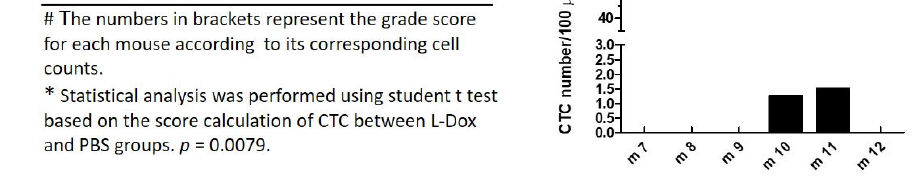
Figure 4. Chemotherapy reduced tumor growth but induce CTCs in vivo. ( A ) Mice treated with L-Dox at a dose of 5 mg/kg once/week for 3 weeks (red arrows indicate L-Dox administration) showed a significant suppression of tumor growth and tumor weight. Data are presented as mean + SEM, N = 6. p -value was calculated with a two-sided unpaired Student’s t test. ( B ) CTCs were captured and identified in both groups of mice. Scale bar, 40 µ m. ( C ) Table listing the levels of CTCs detected in mice treated with L-Dox or PBS. Statistical analysis was performed based on the grading score system according to the CTC count of each mouse (score 1: 0 CTCs; score 2: 0–10 CTCs; score 3: 10–100 CTCs; score 4: >100 CTCs) using a two-sided unpaired Student’s t test, showing significant differences between the L-Dox and PBS groups; p = 0.0079. ( D ) CTC numeration for each mouse in the L-Dox- and PBS-treated